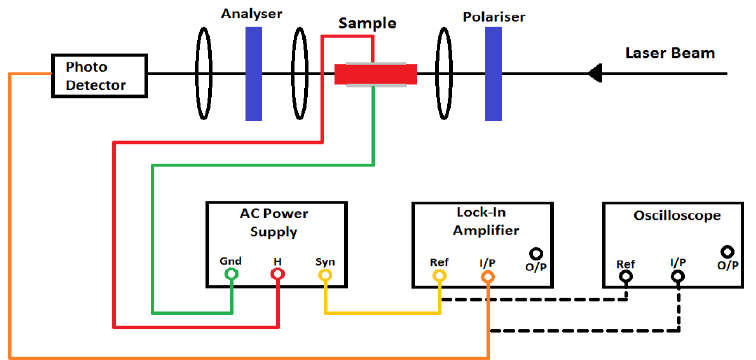
Figure 1. Experimental set-up for measurement of quadratic electro-optic effect/Kerr coefficient.